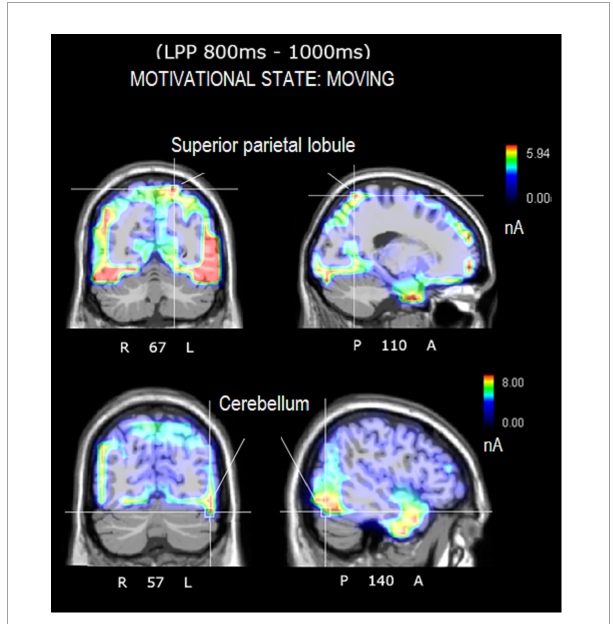
FIGURE7 Axial, sagittal, and coronal brain sections showing the location and strength of electromagnetic dipoles explaining the surface LPP potential during the desire-to-move condition. Note that participants had to remain absolutely still and motionless during EEG recording.